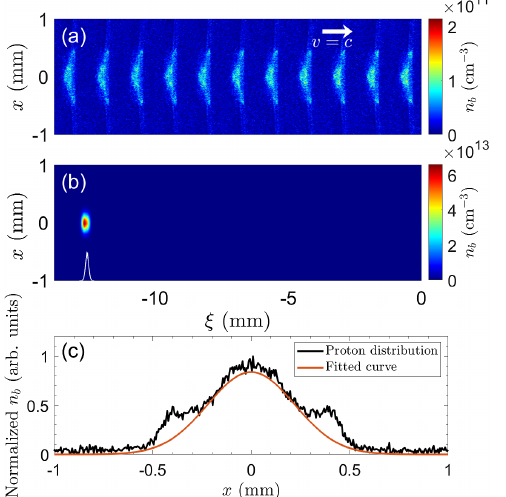
FIG. 4. (a) Eleven self-modulated proton bunches used for the APL simulation. (b) An electron bunch with an rms beam size of 100 μ m was placed between the 10th and 11th proton bunches from the right. The propagation direction of the beam is toward the right. (c) Transverse density distribution of a single proton